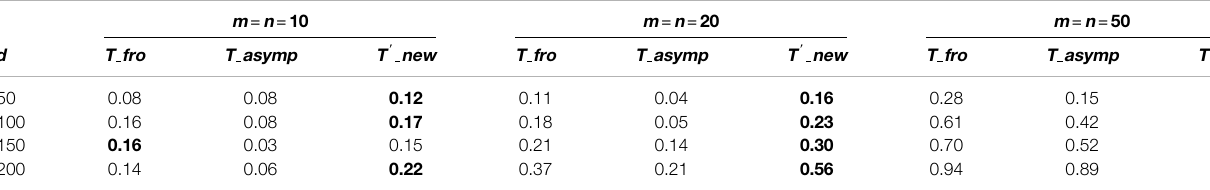
TABLE 3 | Power comparison of different tests for undirected graphs with varying sample sizes. m = n = 10